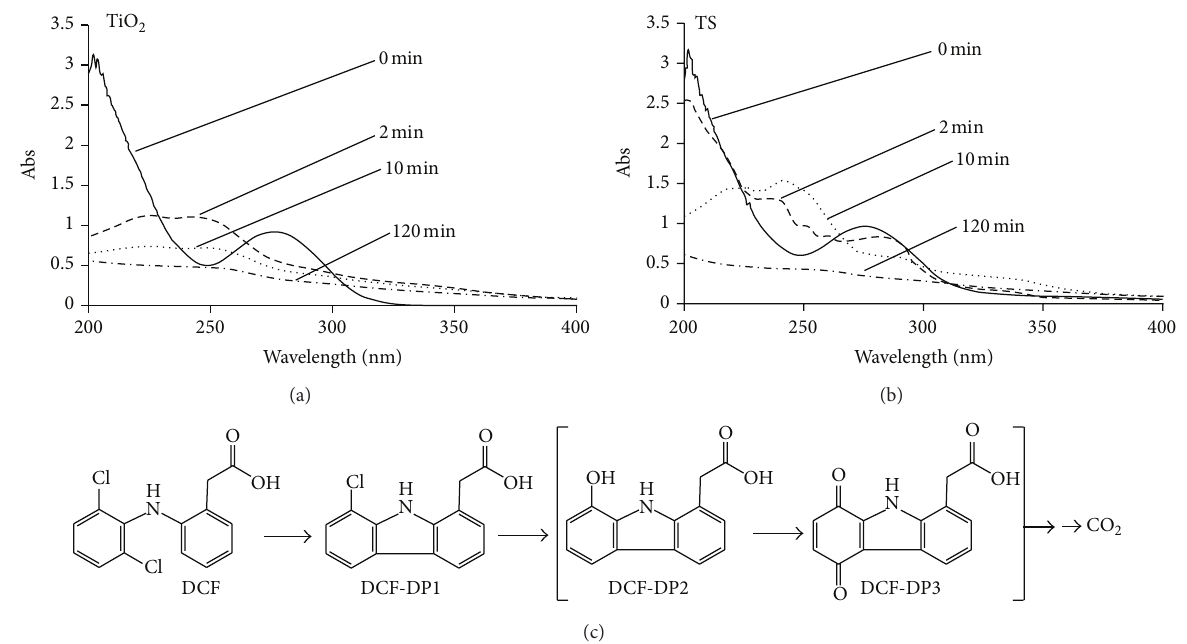
Figure 3: Selected absorption spectra of DCF recorded at different reaction times in the presence of (a) TiO 2 and (b) TS. (DCF (solid line), with photoreaction spectra after 2 min (dashed line), 10min (dotted line), and 120 min (dotted-dashed line)). (c) Photodegradation pathway proposed for DCF in the presence of TiO 2 and TS catalysts with hypothesized carbazole intermediates , shown in square brackets .